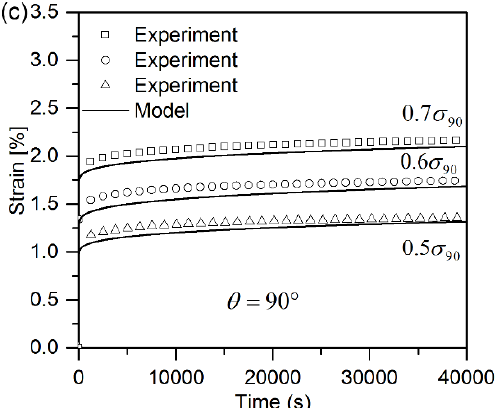
Figure 3. Strain ‐ time curve for quasi ‐ UD E ‐ glass/polypropylene composite under off ‐ axis loading with three creep loading levels: ( a ) 10° off ‐ axis samples; ( b ) 20° off ‐ axis samples and ( c ) 90° off ‐ axis samples.